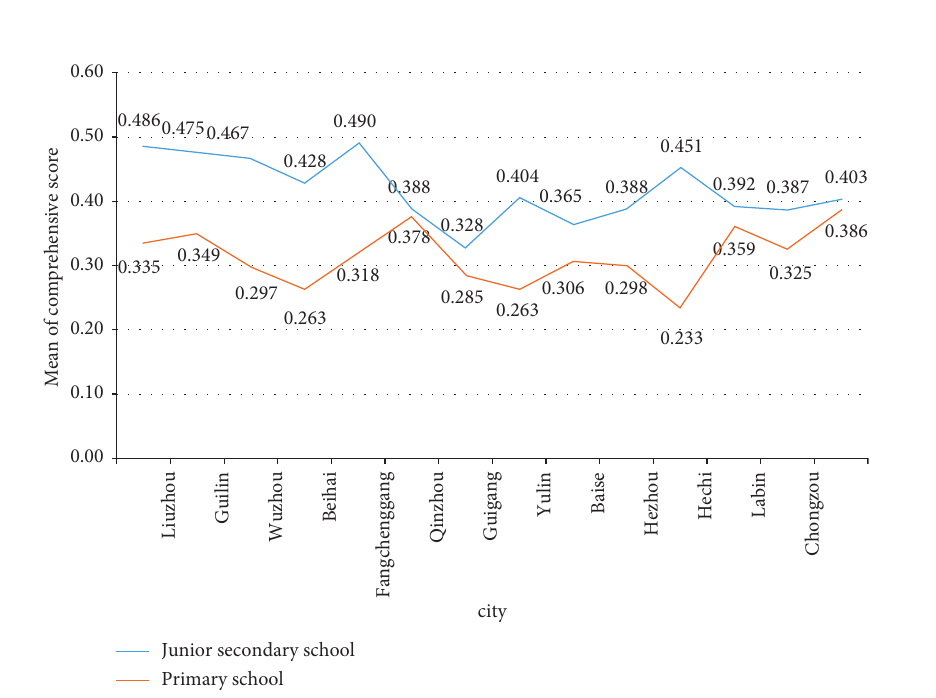
Figure 1: Mean of comprehensive evaluation.